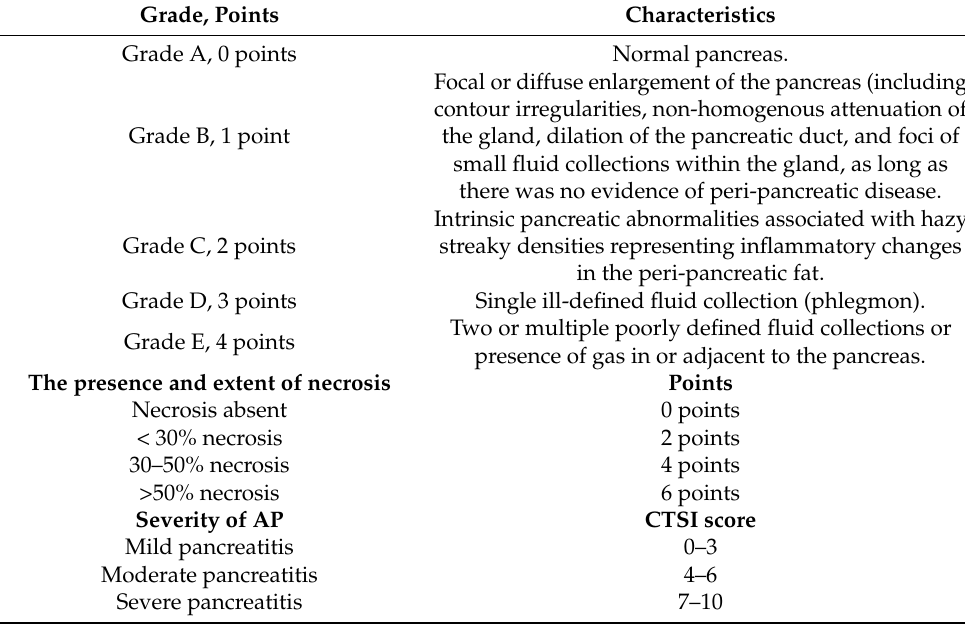
Table 4. Balthazar CTSI-scoring.